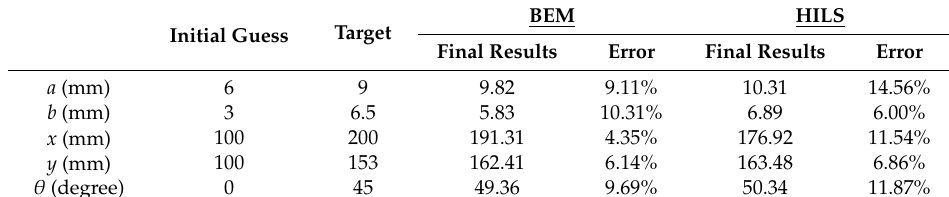
Table 3. Hole identification of composite plate.